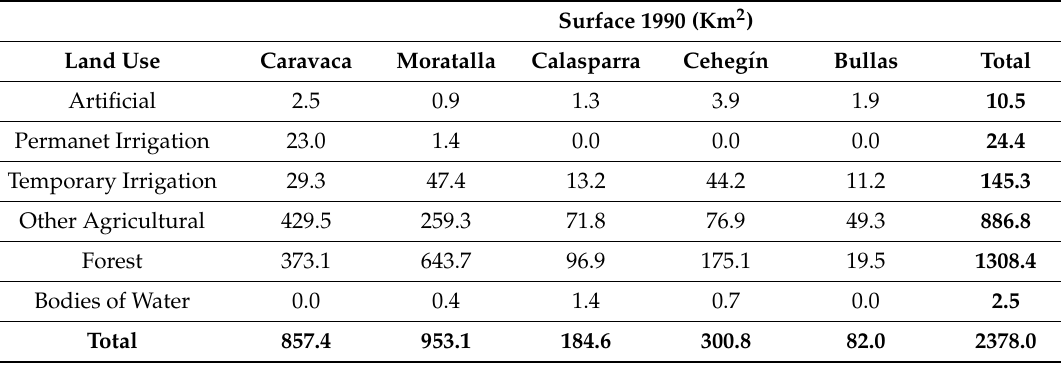
Table 3. Distribution of coverage and land use by municipalities (1990). Surface 1990 (Km 2